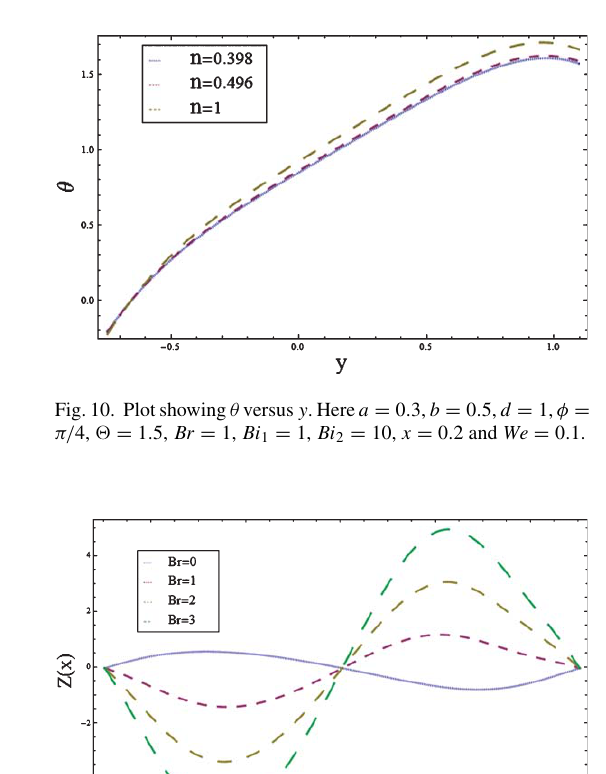
= 1, Bi = 10, n = 0 . 398 and We = 0 . 1. 1 2